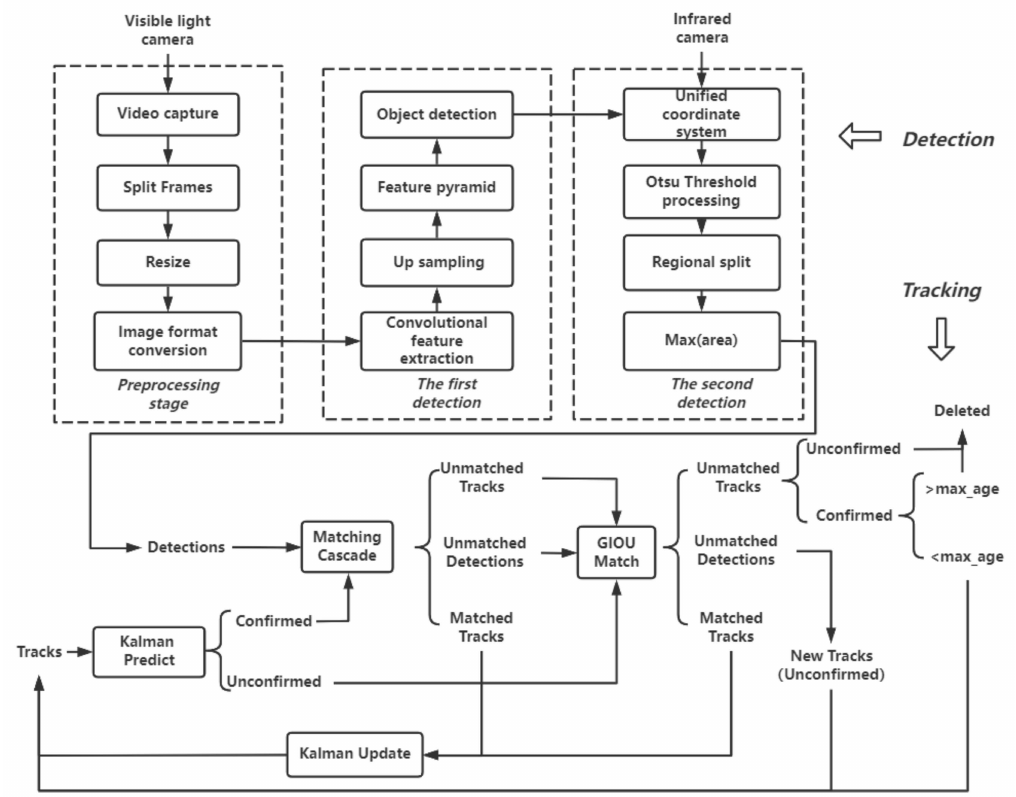
Figure 1. General framework of ship chimney detection and tracking